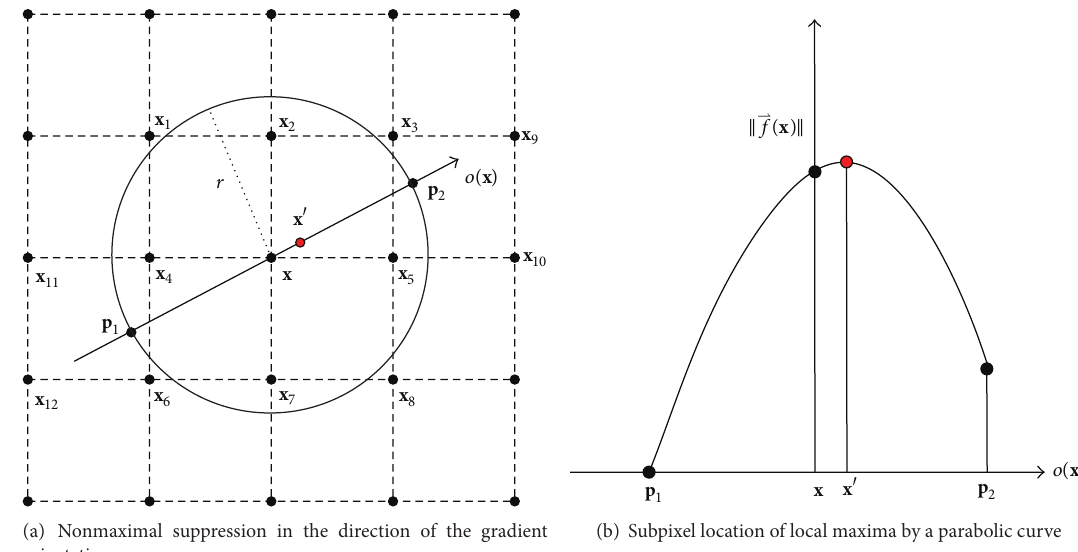
(b) Subpixel location of local maxima by a parabolic curve Figure 1: Non-maximal suppression and sub-pixel location of an edge